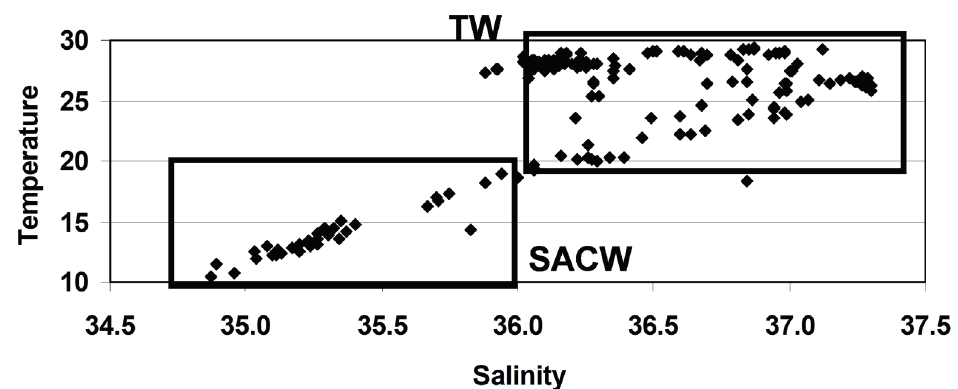
Figure 2 - Temperature-salinity